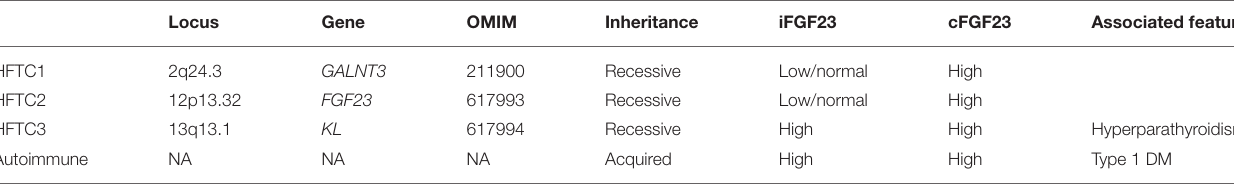
TABLE 1 | Causes of hyperphosphatemic tumoral calcinosis. Locus Gene OMIM Inheritance iFGF23 cFGF23 Associated features HFTC1 2q24.3 GALNT3 211900 Recessive Low/normal